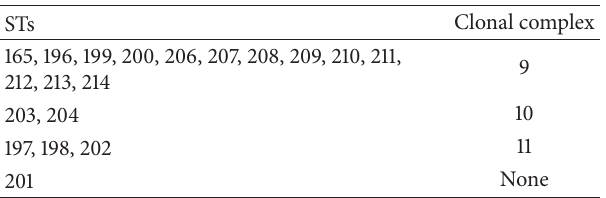
Table 4: Summary of the STs from this study and their respective clonal